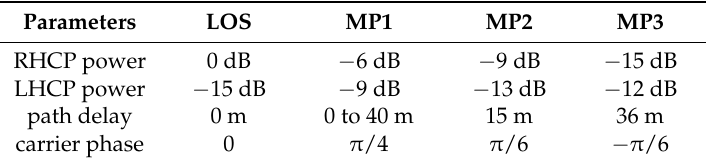
Table 7. The parameters of the signals in the four-path simulation.